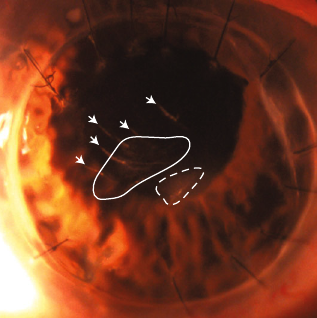
Figure 4: Slit-lamp photograph of the right eye 23 months after initial presentation. The “ branch-like ” in fi ltrates were still visible centrally (solid outline). Multiple linear needle tracks from the intrastromal injections were in the paracentral cornea stroma (arrowheads). The triangular 1.5mm anterior stromal haze was stable in appearance (dashed